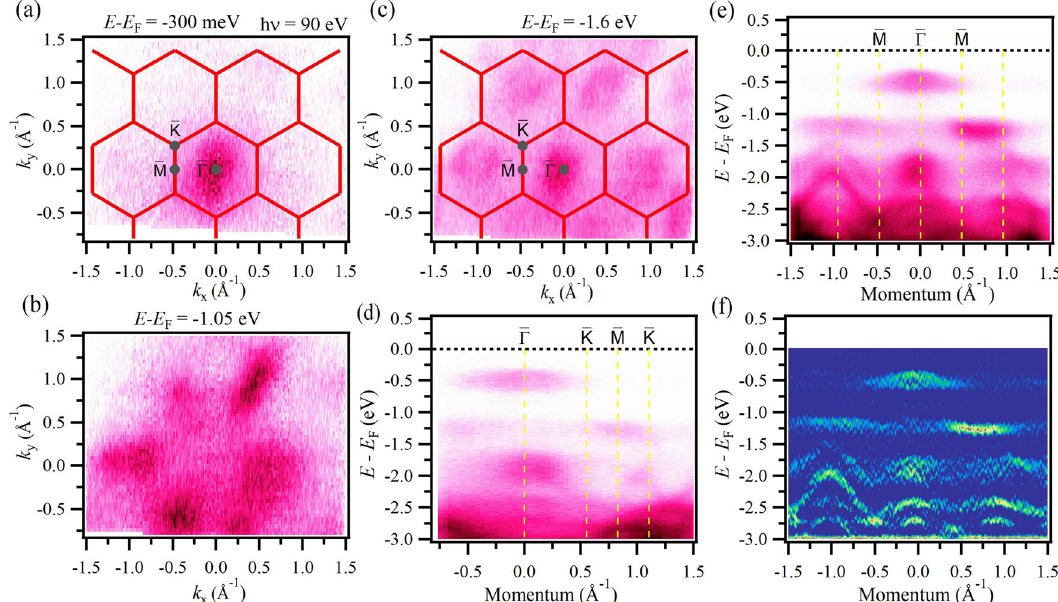
Fig. 2 ARPES measured energy contours (ECs) and band dispersions. a – c ECs at the binding energies of 300 meV, 1.05, and 1.6 eV, respectively. Red hexagons represent the BZ with high-symmetry points marked and labeled. d and e Band dispersions along different high-symmetry directions as shown in the plots. f Second derivative plot of ( e ). Data were collected at the ALS beamline 4.0.3 at a temperature of 260 K using a photon source of mono- energy 90